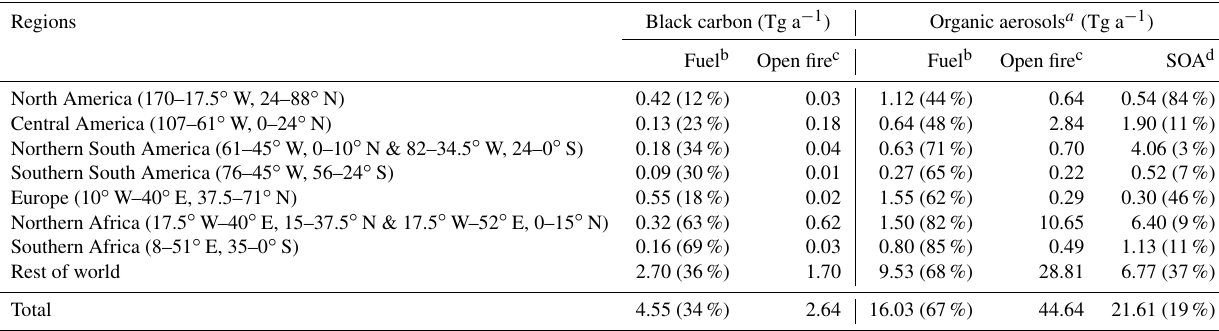
Table 2. GEOS-Chem emissions of carbonaceous aerosols in January–April 2014.